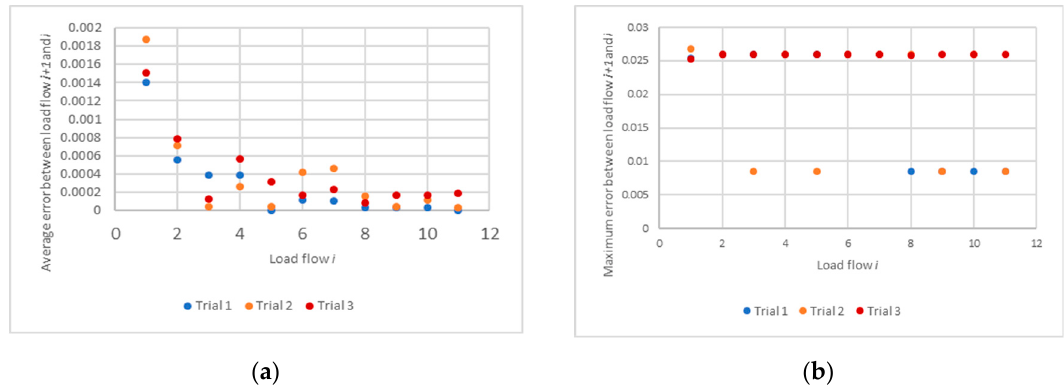
Figure 15. Metrics measured for Case 2.2. ( a ) Average error ∆ of the secondary voltages between the results of consecutive power flows. ( b ) Maximum absolute error ∆ max of the secondary voltages between the results of consecutive power flows.